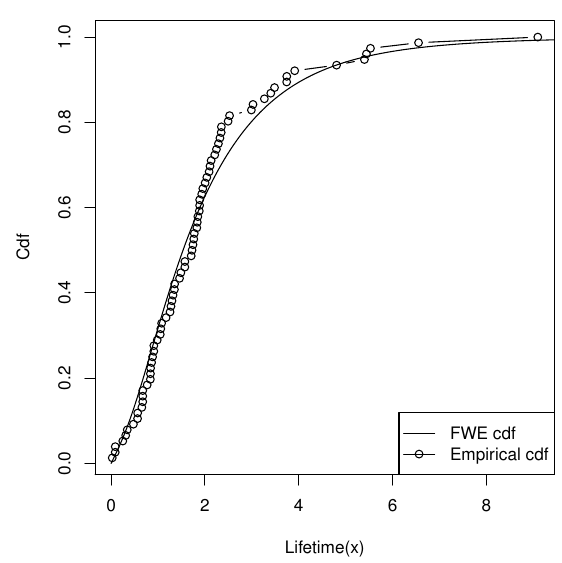
Figure 5. Fitted cdf plot of the FWE distribution for failure times